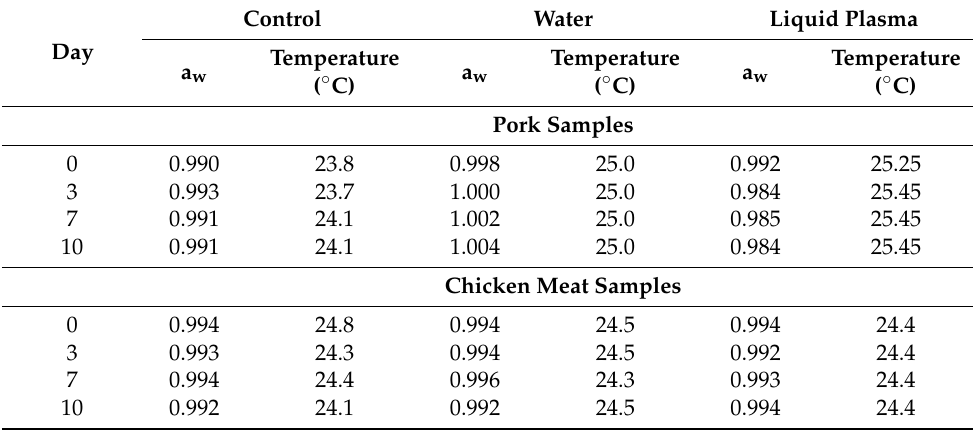
Table 11. Water activity of pork and chicken meat